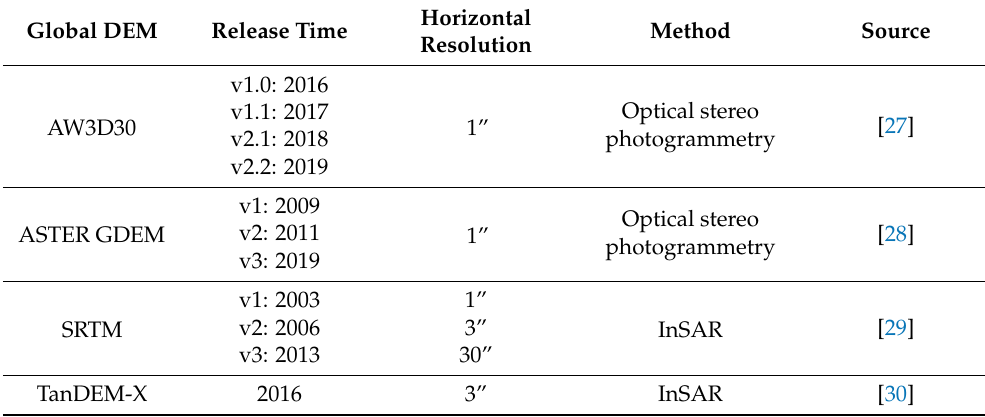
Table 1. Overview of global digital elevation models (DEMs) evaluated in this study. Global DEM Release